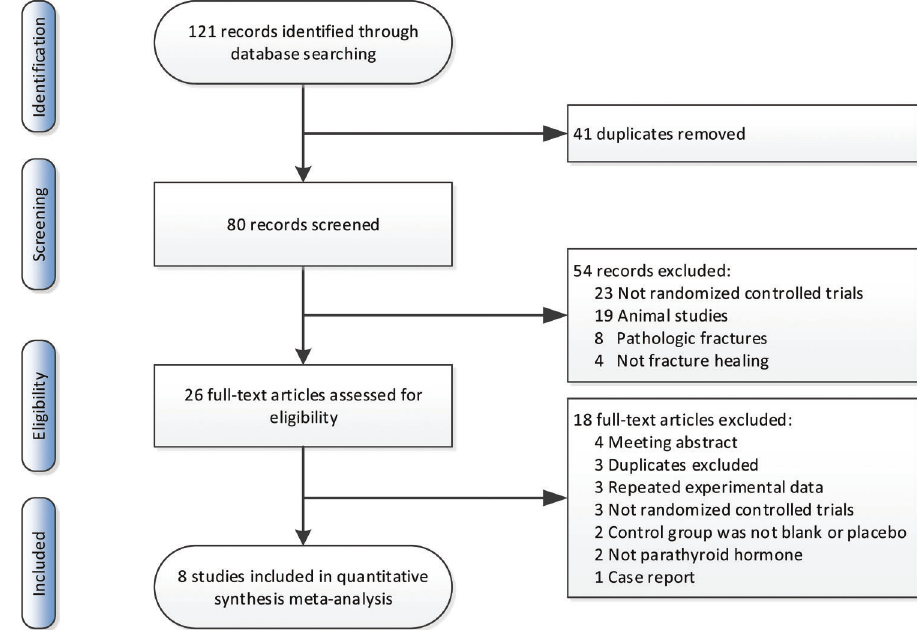
Figure 1 - Flow diagram of the study selection